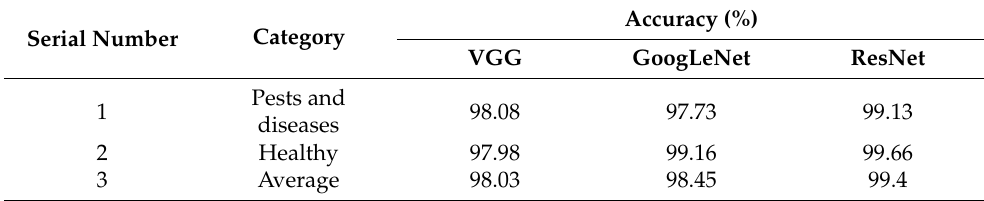
Table 4. The accuracy of the models on the test set.